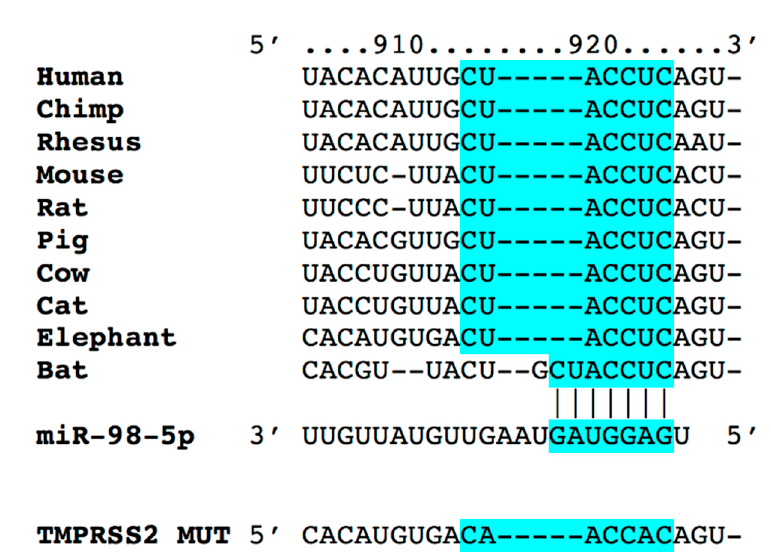
Figure 1. Identification of miR-98-5p as modulator of transmembrane protease serine 2 (TMPRSS2). Complementary nucleotides between the target region of TMPRSS2 3 ′ -UTR (in light blue) and hsa-miR-98-5p are highly conserved across different species.